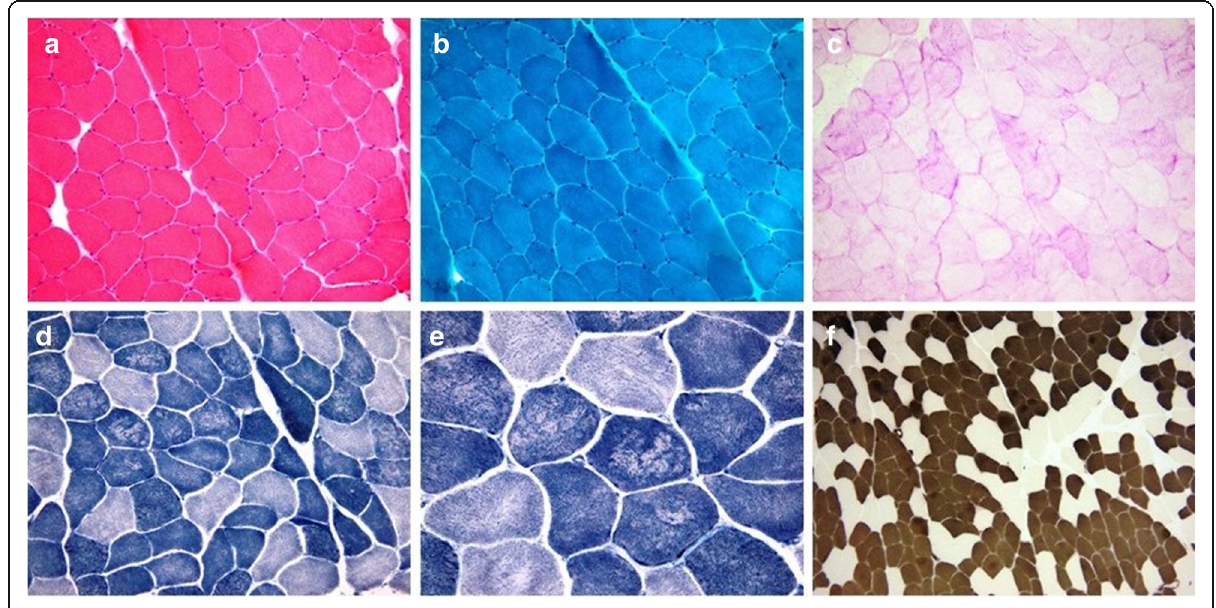
Fig. 4 Cryosections of the left deltoid muscle biopsy specimen, frozen in isopentane cooled in liquid nitrogen were used for routine histological staining and histochemical techniques. Hematoxylin and Eosin (HE 200x, panel a ), Gomori trichrome (GT 200x, panel b ) and Periodic Acid Schiff (PAS 200x, panel c ) staining revealed unspecific minimal myopathic changes with mild variation in the fiber size and rare atrophic, angulated fibers. On reduced nicotinamide adenine dinucleotide tetrazolium reductase (NADH-TR 200x, panel D and 400x, panel e ) unevenness of stain and multiple core-like areas devoid of enzyme activity in both fiber types, but mainly in type I fibers were identified. A nonspecific predominance of type I fibers (dark color) was highlighted by adenosine triphosphatase staining (ATPase pH 4,35,100x, panel f